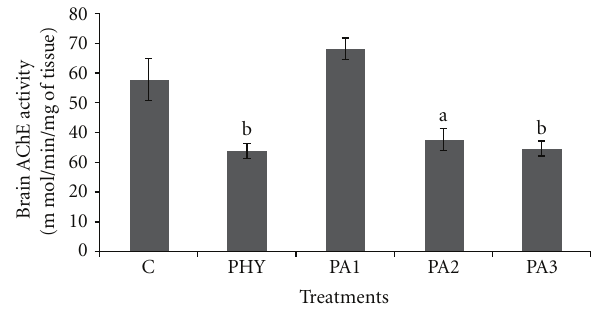
Figure 1: E ff ect of palmatine and physostigmine on brain AChE activity of mice. n = 8 in each group. Values are expressed as Mean